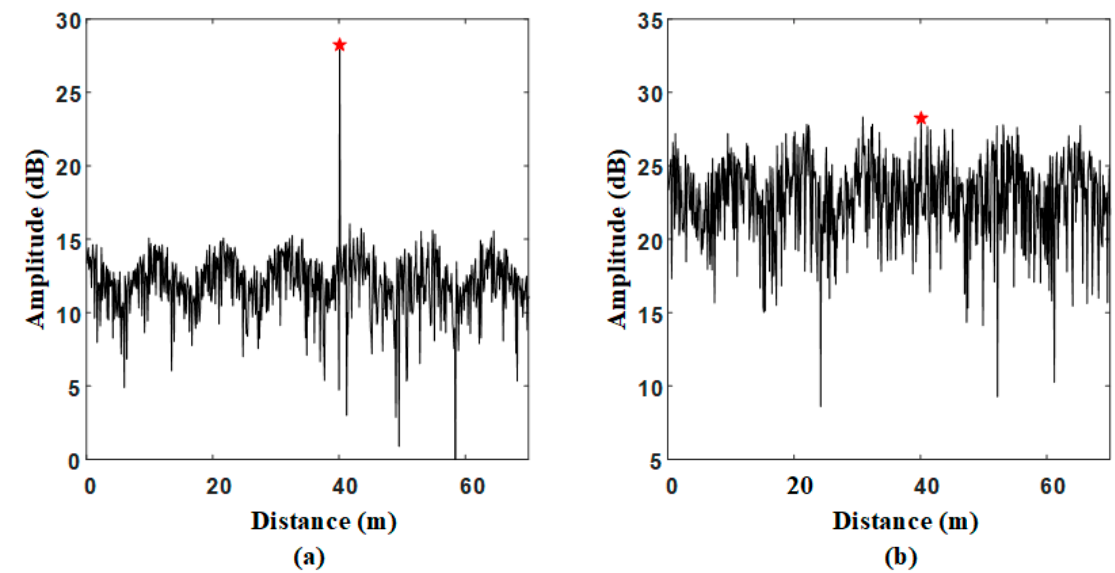
Figure 3. Simulation data: ( a ) Target signals without clutter; ( b ) Target signals with clutter.